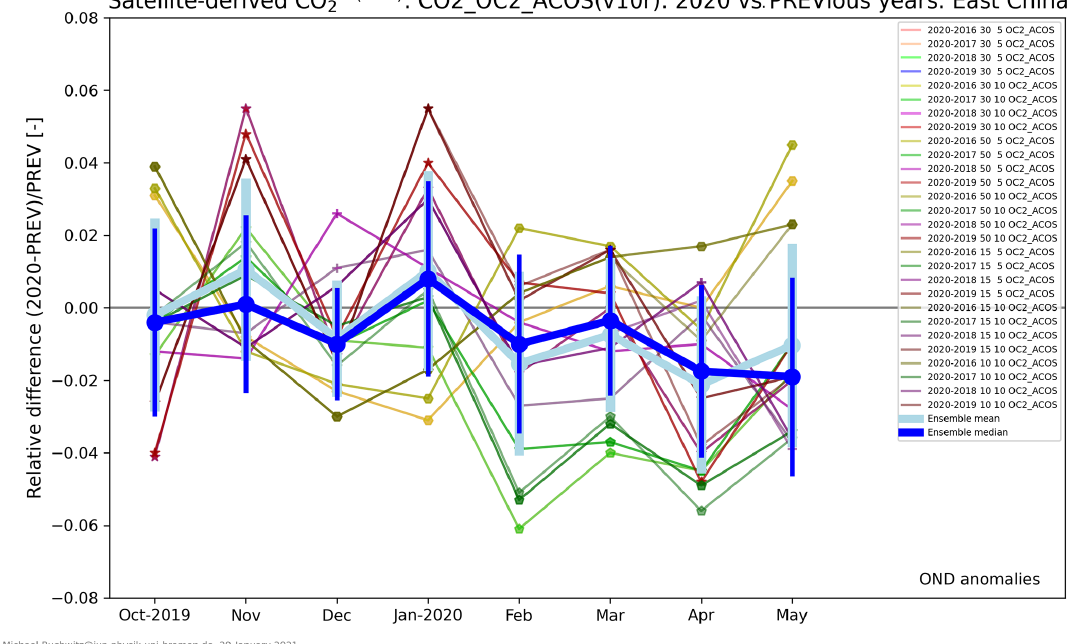
Figure 9. The same as Fig. 8 but with additional combinations of minimum number of observations per day (30 as in Fig. 8 and in addition 50, 15 and 10) and minimum number of days per month (5 as in Fig. 8 and in addition 10) (see